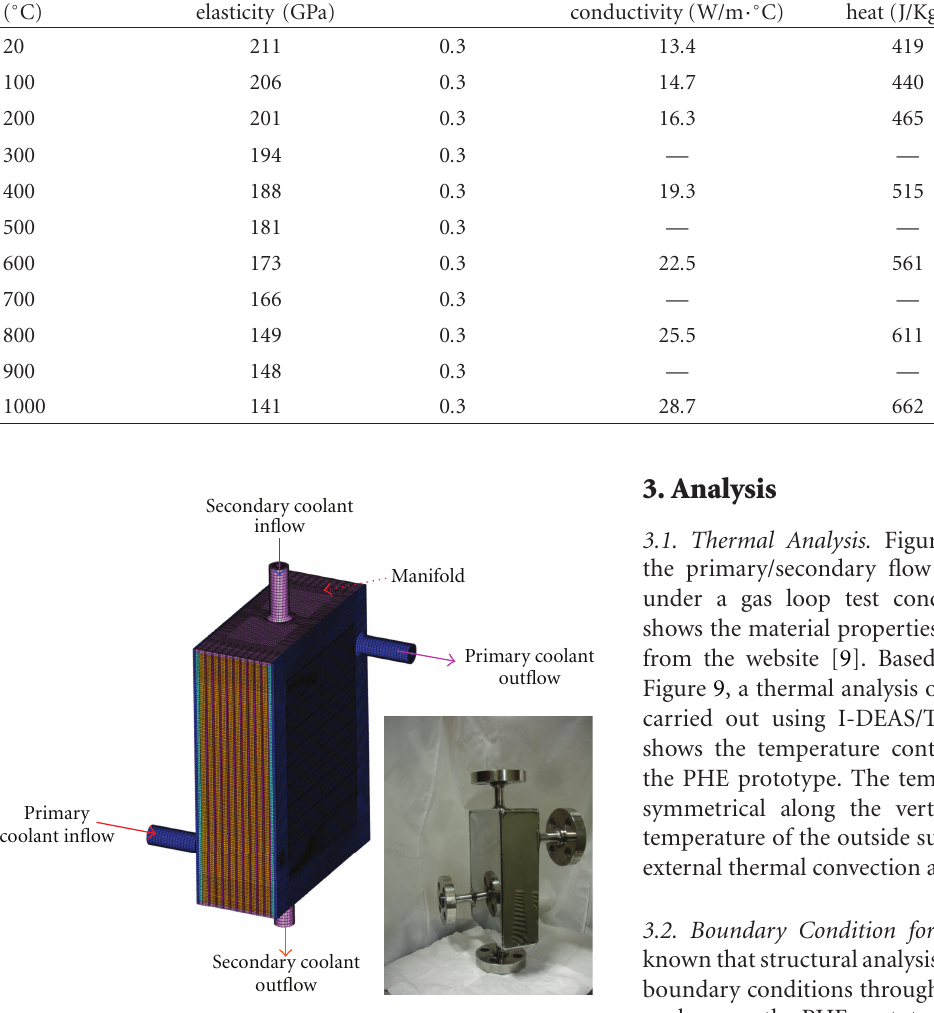
Figure 4: Small-scale PHE